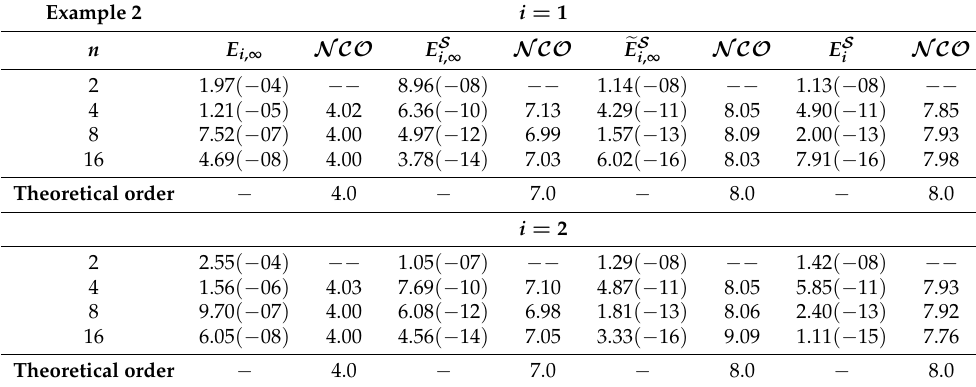
Table 4. Numerical methods based on piecewise linear functions ( r = 2 ) .